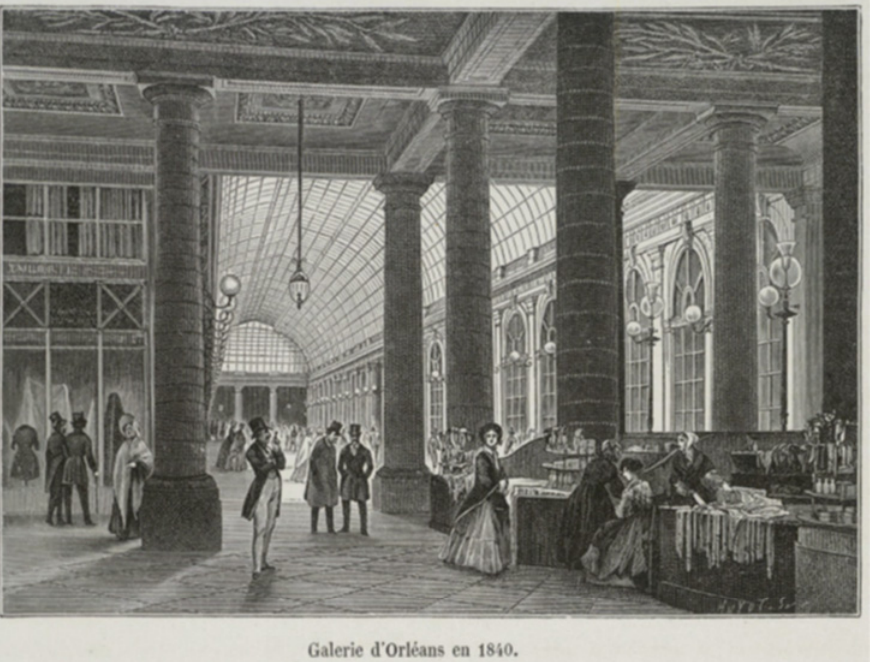
Figure 3. Galerie D ’ Orléans. Iron and glass architecture system for vaulted structures. Fontaine and Rohault, Orléans, France in 1840. Source: Brown University Center for Digital Scholarship engraving of the collection “París, capital of the s. XIX”.